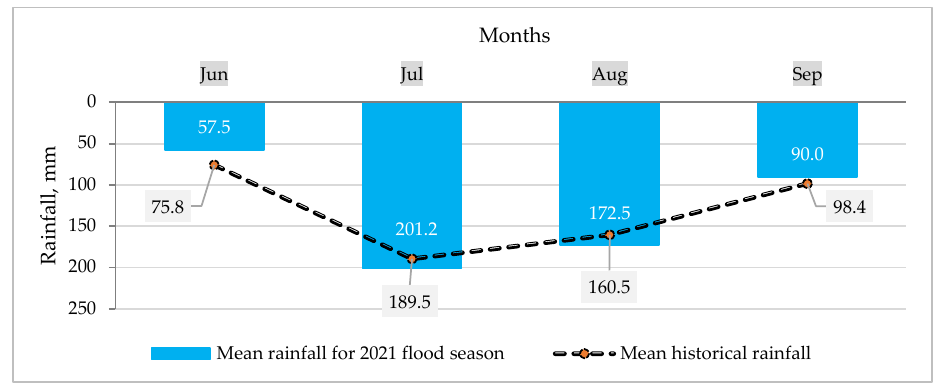
Figure 10. Mean monthly rainfall forecast for the 2021 flood season and historical records.